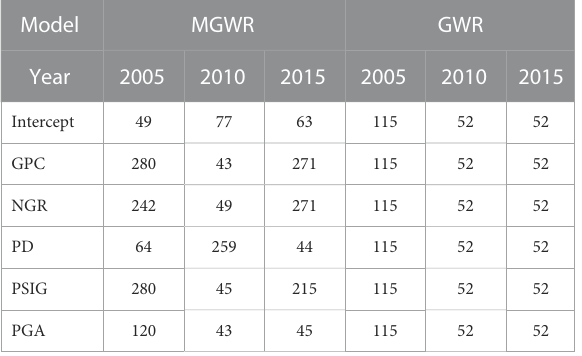
TABLE 4 GWR and MGWR model bandwidth. Model